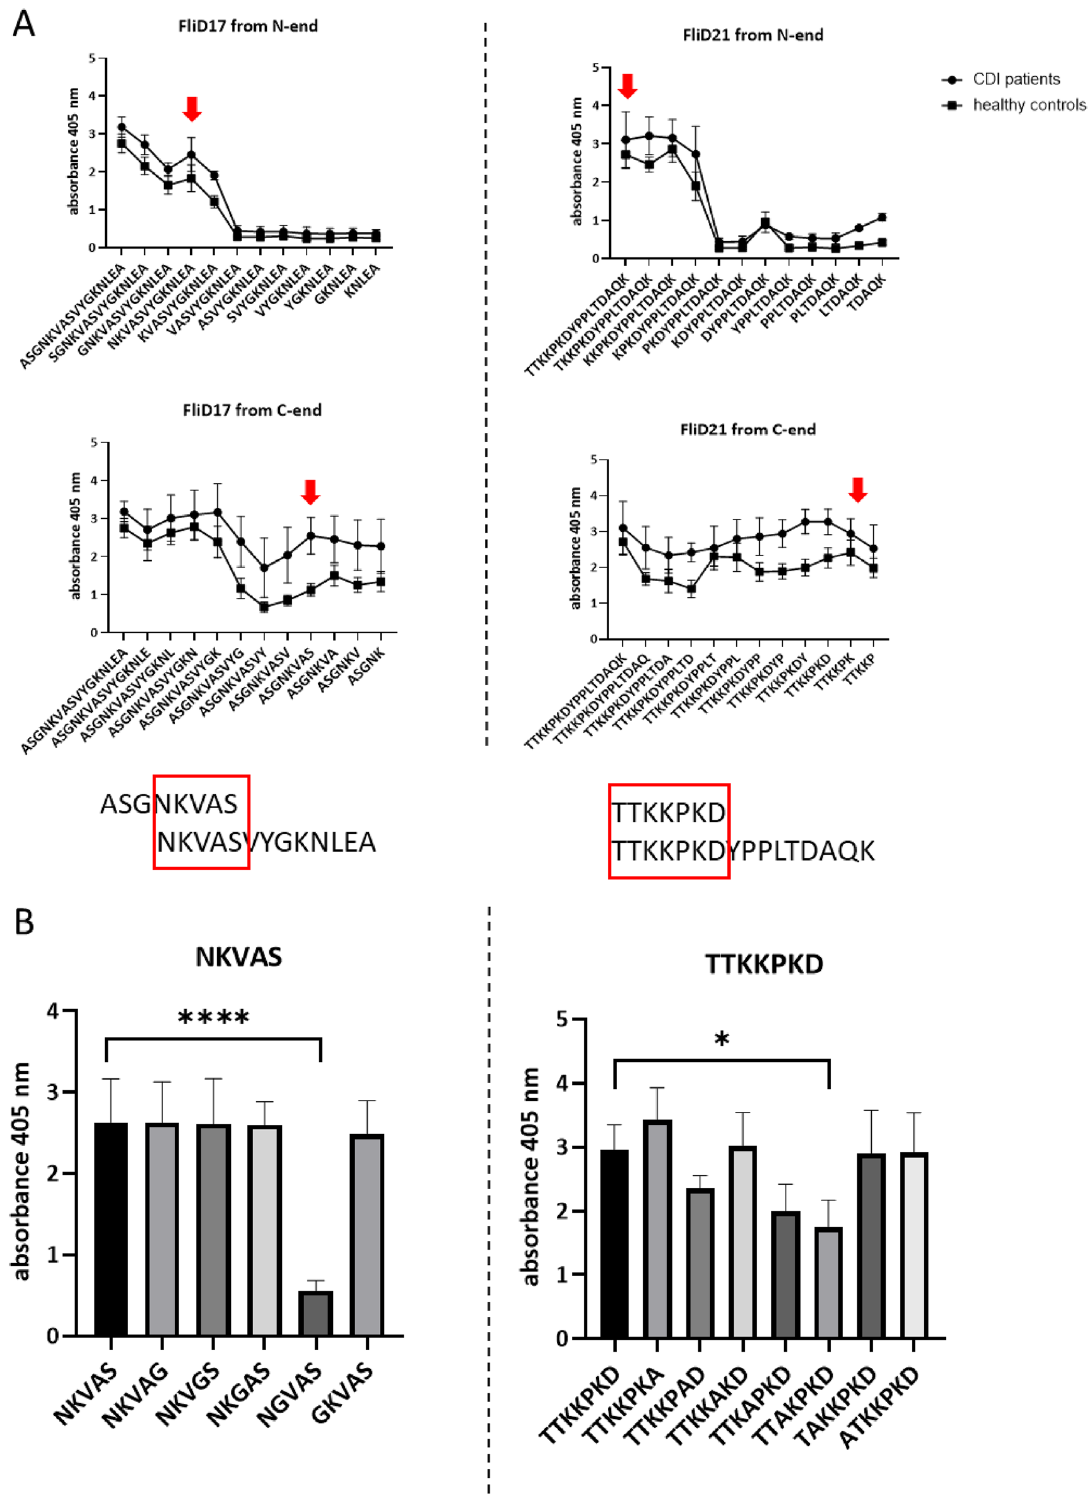
Figure 5. Mapping of C. difficile cap protein epitopes. ( A ) The analysis of the immunoreactivity of the library of truncated peptides of FliD17 and FliD21. Pin-bound ELISA was performed using pooled sera from C. difficile - infected patients and healthy volunteers (1:1000 dilution). Anti-human IgG conjugated with AP were used as secondary antibodies (1:10,000 dilution). Means with ± SD of three measurements are shown. ( B ) The “alanine walk” analysis of NKVAS and TTKKPKD epitopes. Pin-bound ELISA was performed using pooled C. difficile - infected patients’ sera (1:1000 dilution). Anti-human IgG conjugated with AP were used as secondary antibodies (1:10,000 dilution). Means with ± SD of three measurements are shown. Data analyzed with one-way ANOVA; * p < 0.0332, ** p < 0.0021, *** p < 0.0002, **** p <